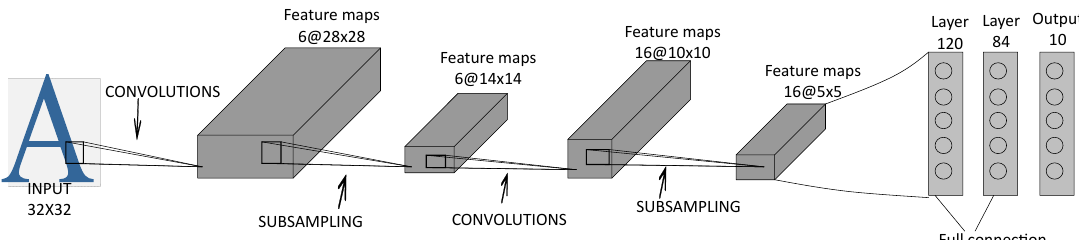
Figure 2. Representation of the LeNet-5 [19]